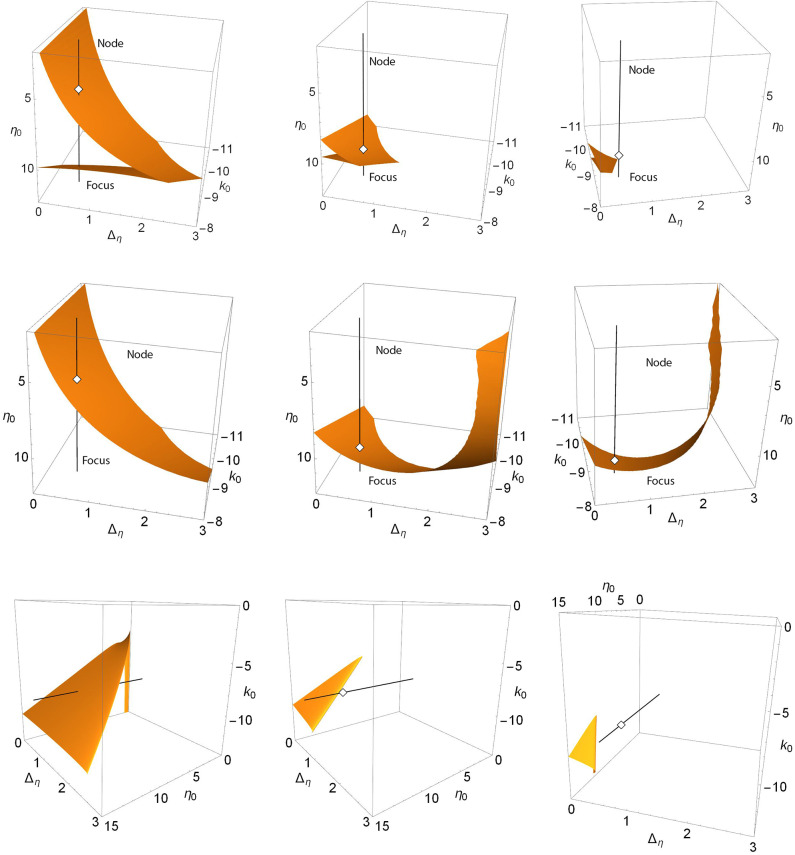
Case 2: Plots of the saddle-node surface (top), the node-focus surface (middle), and the Hopf surface (bottom) for Δk = 0.0 (left), 1.3 (middle), and 1.7 (right), with n = 2. The black line corresponds to k0 = −9.0 and Δη = 0.5, and is the path traversed along η0 in the bifurcation diagrams shown in Figure 2. Open diamonds are node-focus transitions. The views in the upper and middle right panels have been rotated for clarity. In particular, the black line does not intersect the SN surface for Δk = 1.7. The view in the lower panels is also rotated to better show the structure.